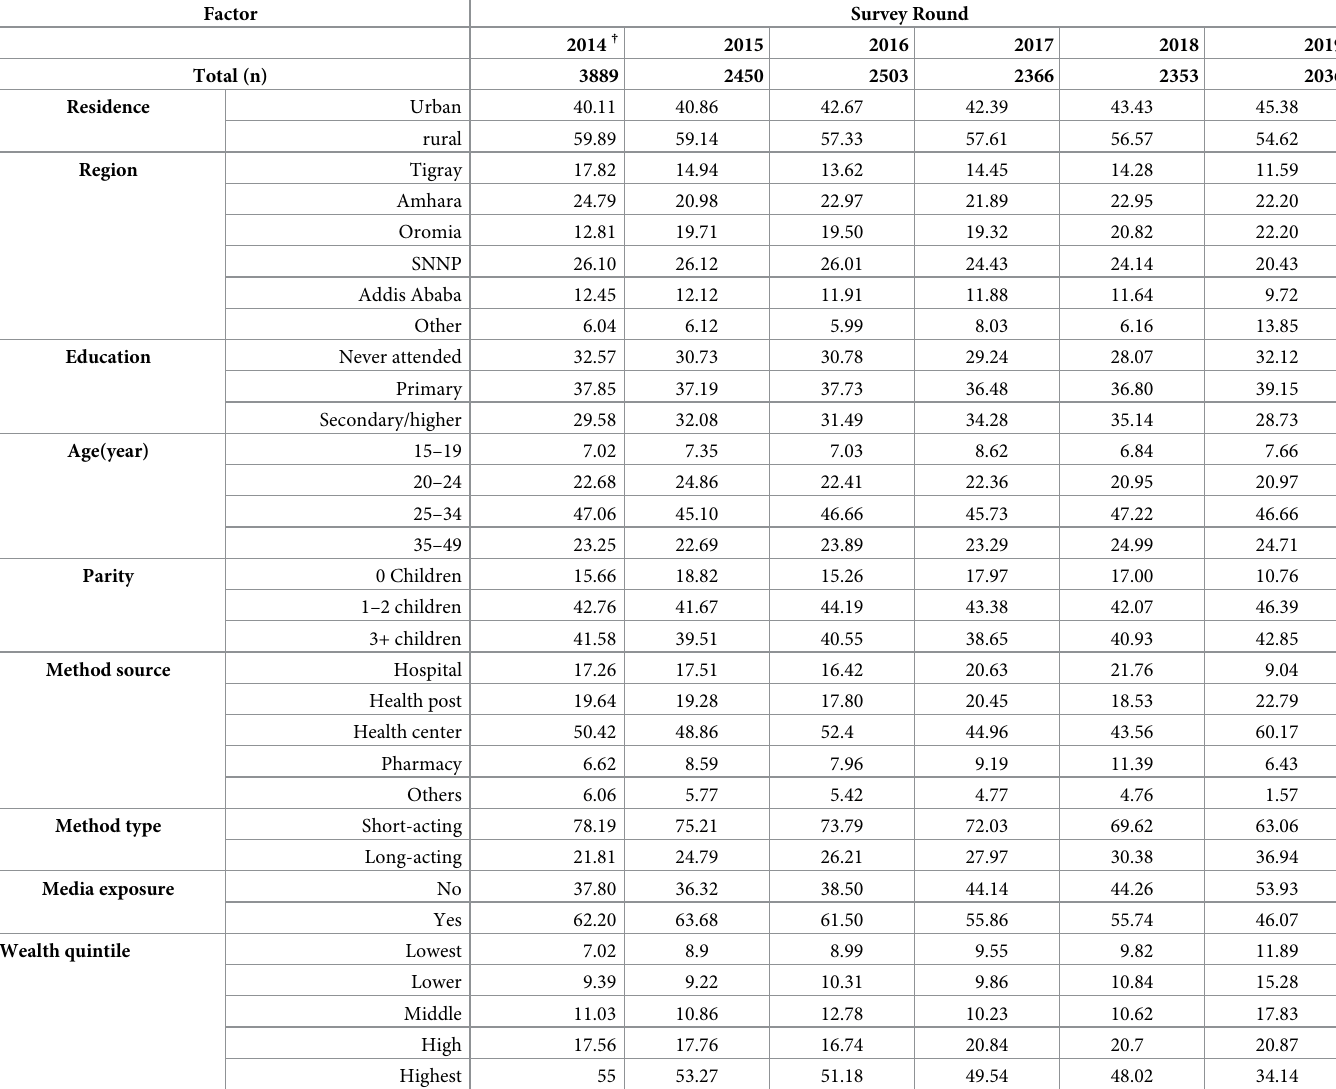
Table 2. Sample characteristics of PMA survey respondents across survey